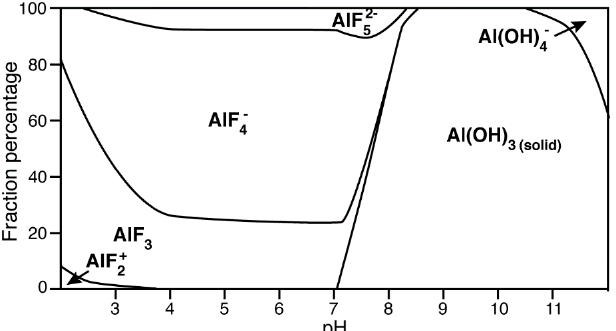
Figure 8. The di ff erent species of AlF x at di ff erent pH. The diagram was generated using ChemEQL [123], Figure 8. The different species of AlF x at different pH. The diagram was generated using ChemEQL